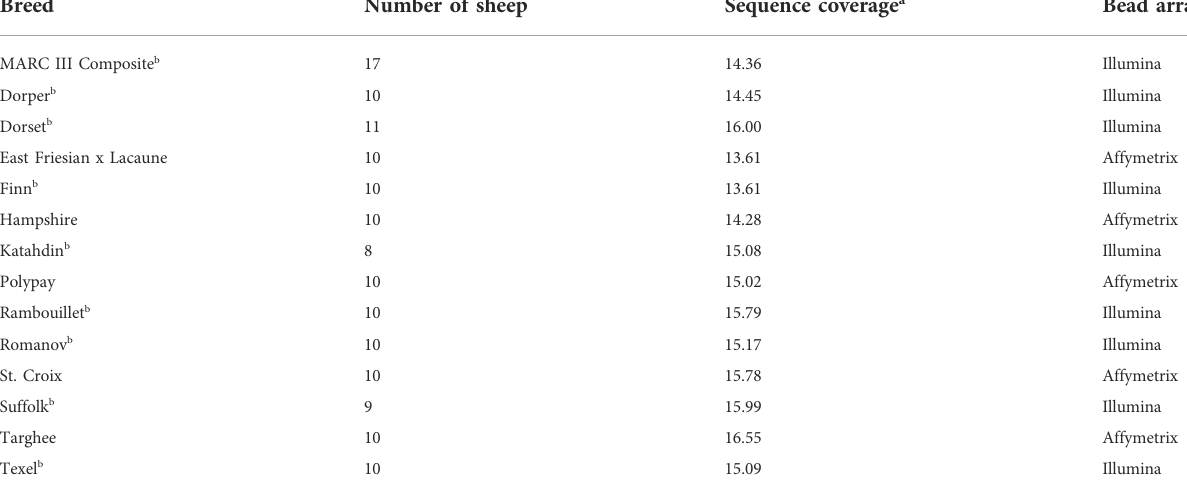
TABLE 1 Data from the U.S. sheep breeds used.